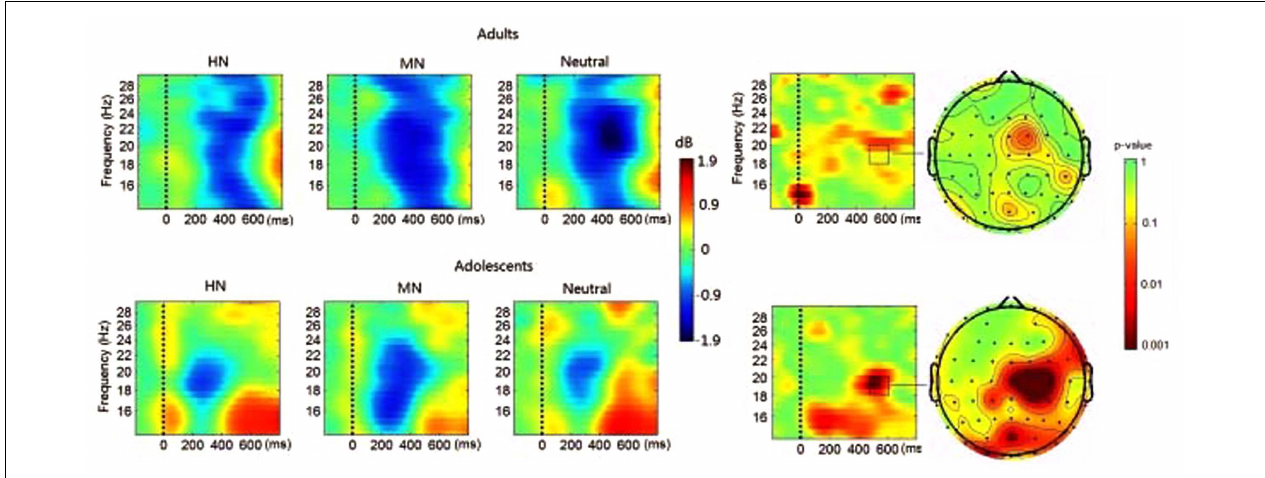
FIGURE 6 | (Left) The averaged beta rhythm oscillations during HN, MN and Neutral conditions at Cz over time ( x -axis, 0 denotes picture onset) and frequency ( y -axis, 14–30 Hz). Blue color indicates power decrease relative to pre-stimulus baseline and red color indicates power increase relative to the baseline. (Right) The time-frequency map and the scalp distribution of the emotion effect across HN and MN stimuli in 500–600 ms (Right, red color denotes smaller p values and stronger significance level).